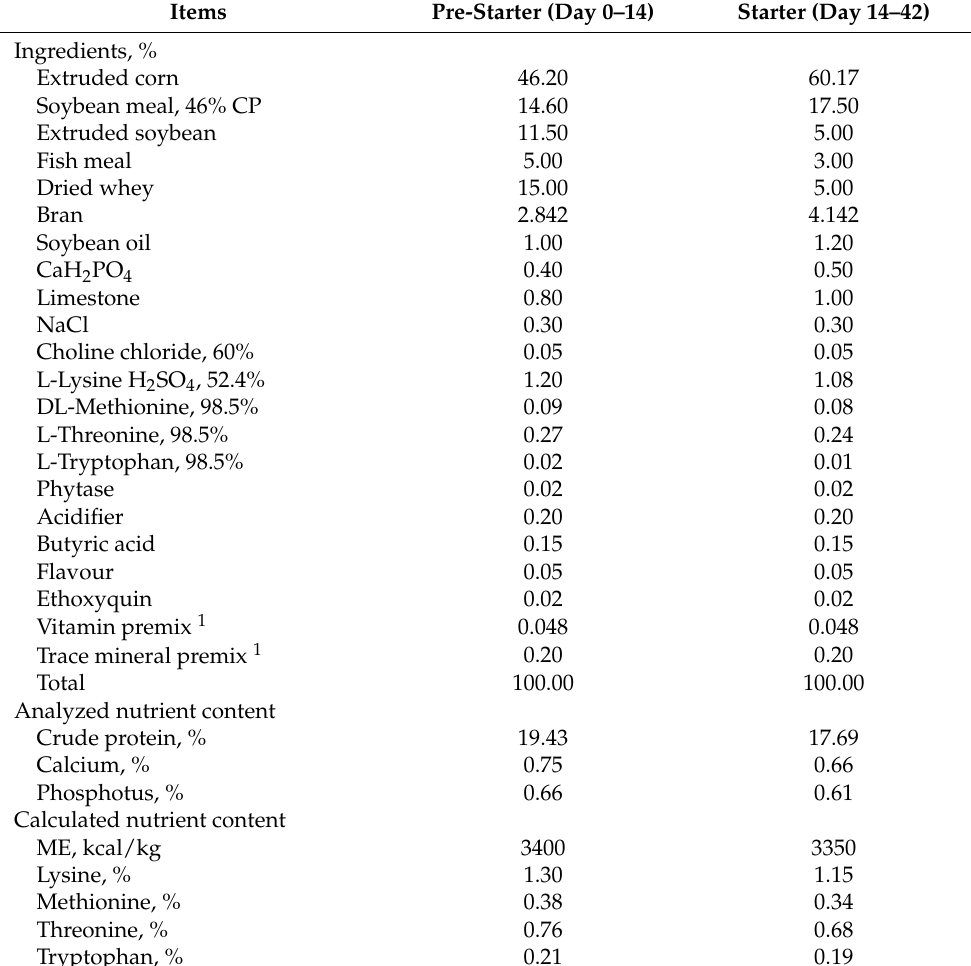
Table 1. Ingredient and nutrient composition of the basal diet (as fed